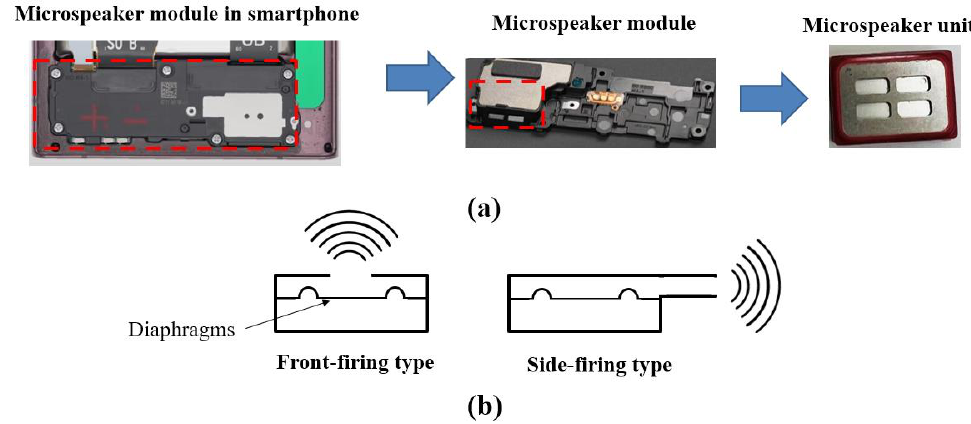
Figure 1. Microspeaker module: ( a ) microspeaker module and unit; ( b ) types of front chamber.